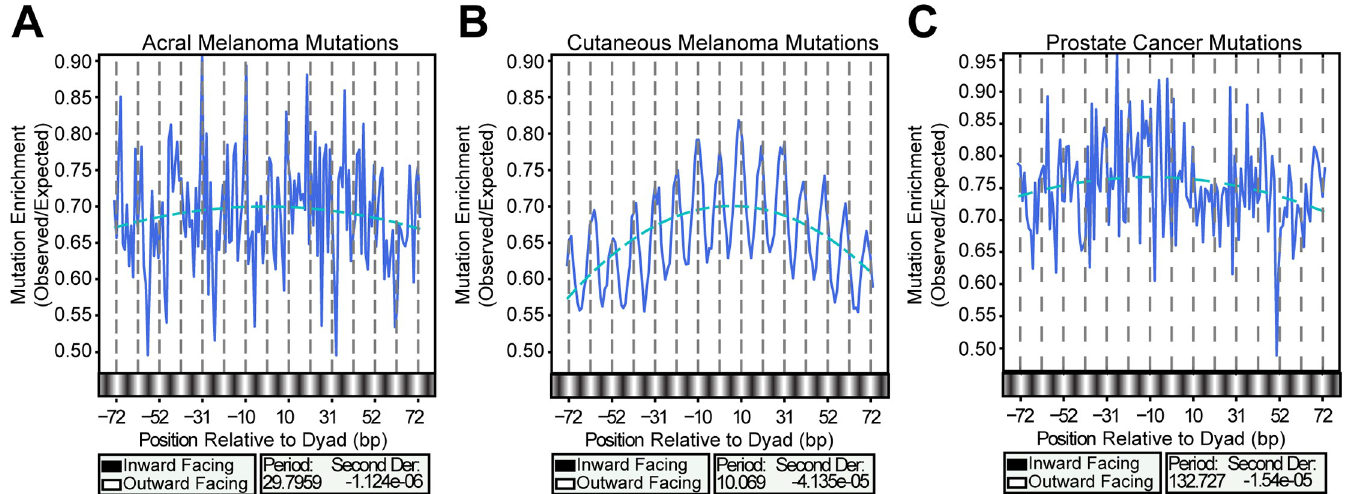
Fig 2. Effect of melanoma subtype on nucleosome-associated mutation patterns. Enrichments of mutations occurring in dipyrimidines in ( A ) acral melanomas ( B ) cutaneous melanomas, or ( C ) prostate cancer were calculated at nucleosome positions. The cutaneous, but not acral or prostate, mutation enrichment exhibits the same ~10 bp periodicity. As shown in S2 Fig, this was not due to a difference in power.